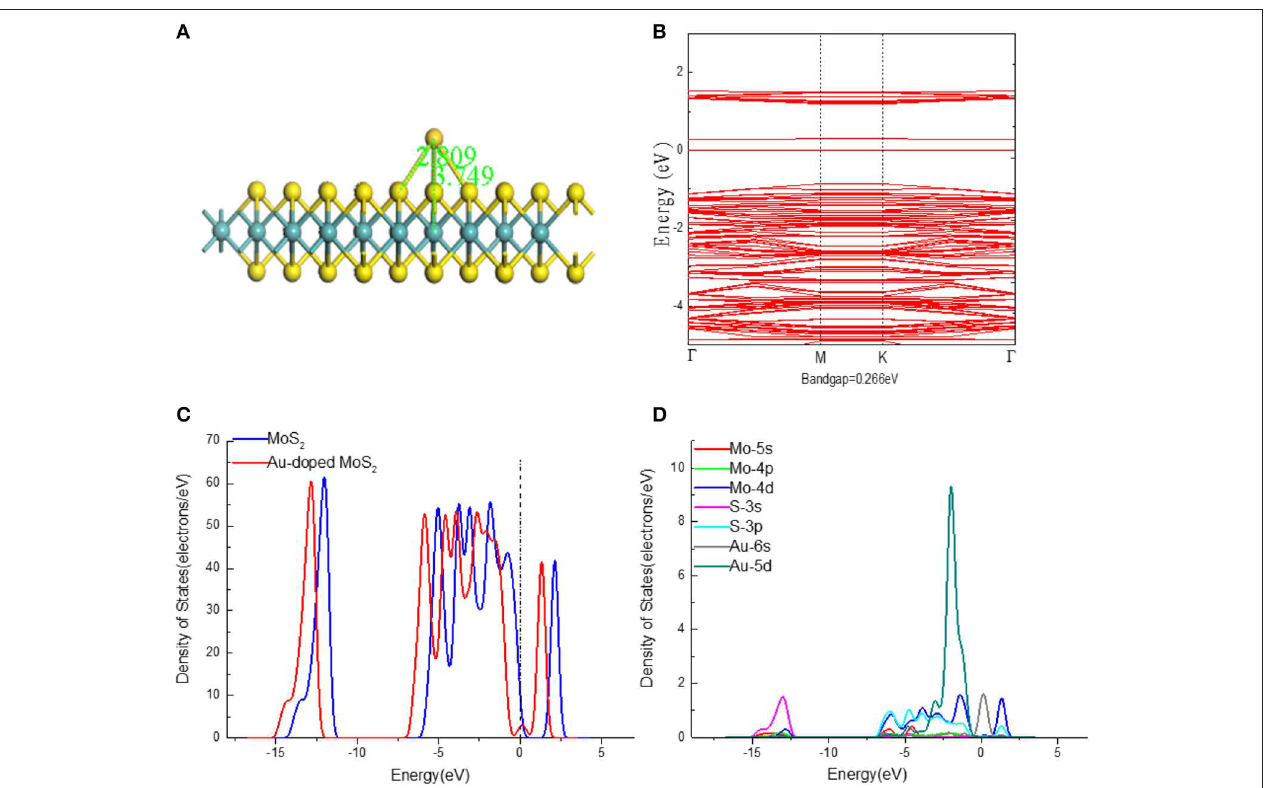
FIGURE 4 | (A) The structures, (B) Band structures, (C) TDOS, and (D) PDOS of Au-doped MoS 2